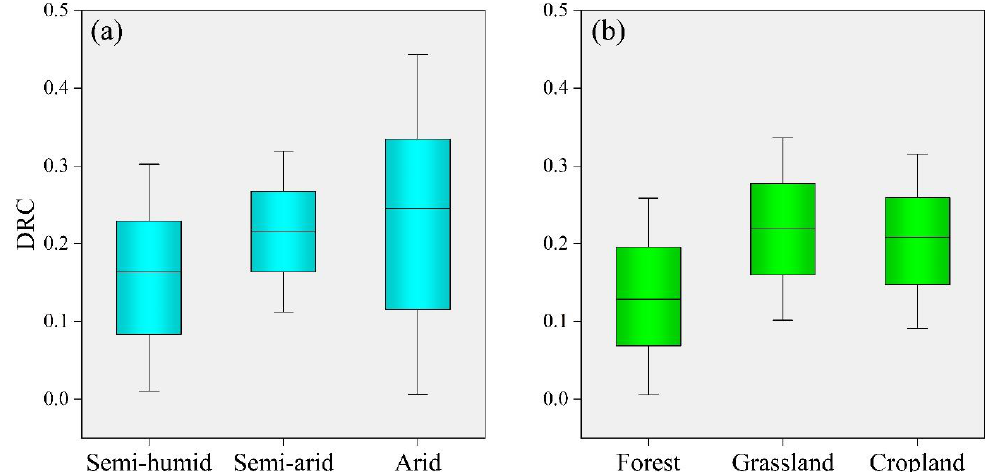
Figure 3. DRC (Drought Resistance Coefficient) of vegetation in different climate zones ( a ) and vegetation biotypes ( b ). Boxplot elements: box = values of 25th and 75th percentiles; horizontal line = median; whiskers = ±1 Standard Deviation (SD).